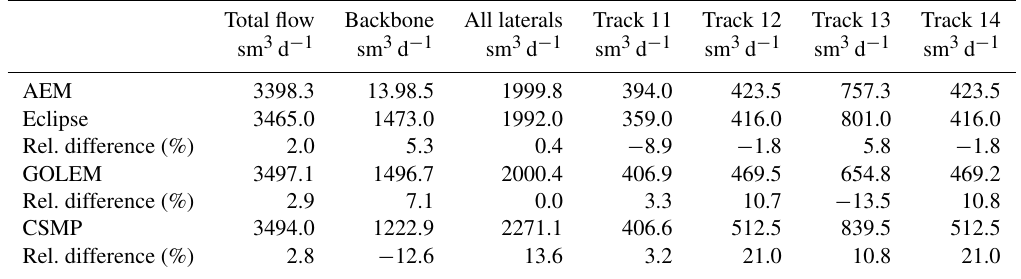
Table 3. Results for all four simulators for case 2: 35 ◦ – deviated well with four laterals (see Fig. 1 the configuration).